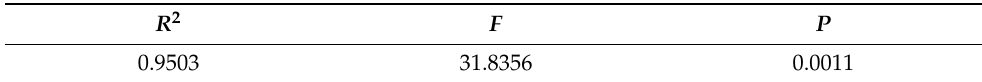
Table 7. Model statistic scale.